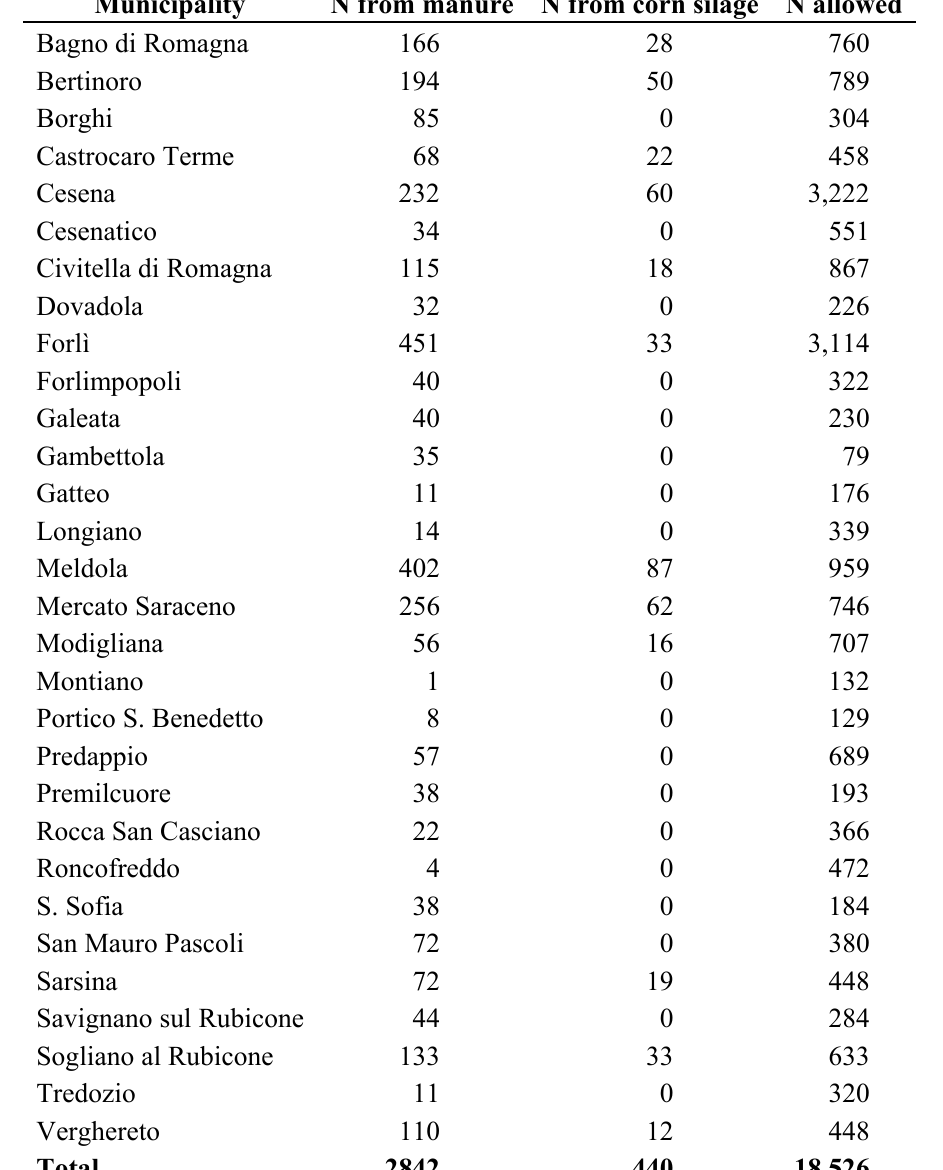
Table 12. Nitrogen production for the single parcel plants and field capacity (all values in Mg N/year).